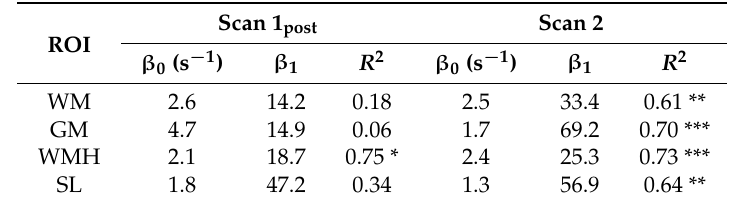
Table 3. Linear regression analysis of change in R 1 ( Δ R 1 ) versus change in R 2 * ( Δ R 2 *) at scan 1 post (immediately post-USPIO) and scan 2 (24–30 h post-USPIO). Changes are calculated relative to scan 1 pre (pre-USPIO) values. Statistically significant associations are indicated by * ( p < 0.05), ** ( p < 0.01) and *** ( p < 0.001).